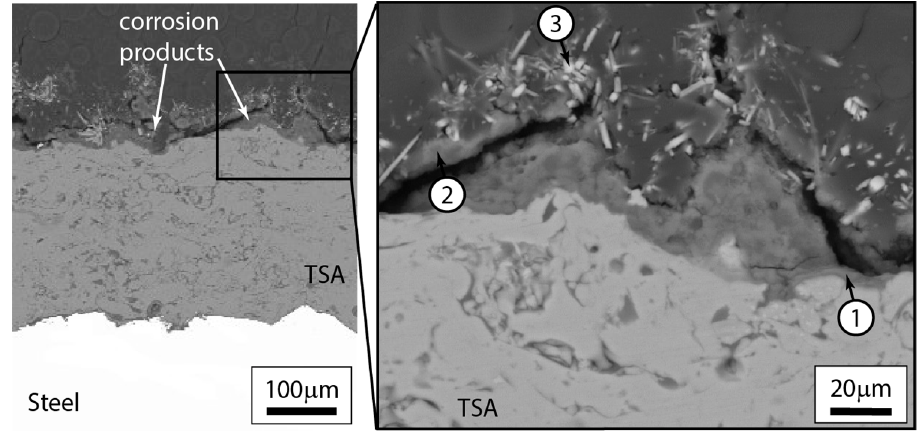
Figure 9. Micrographs of cross-section of TSA on X80 kept at OCP in synthetic seawater. Magnified image is also shown for clarity. EDX patterns were collected from the regions (1, 2 and 3) marked in the figure.